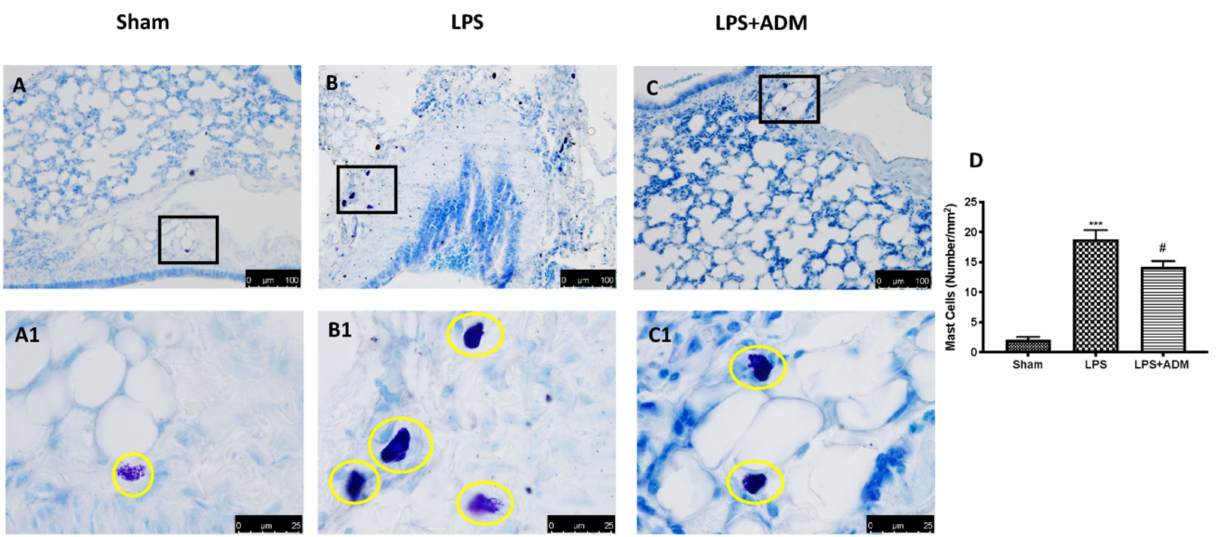
Figure 3. Mast cells indicated by toluidine blue staining: Sham ( A ), LPS ( B ), LPS + ADM 2% ( C ), mast cell count ( D ). A 20 × and 100 × magnification is shown. Data are expressed as the mean ± SEM of N = 6 mice/group. *** p < 0.001 vs. sham; # p < 0.05 vs. LPS.